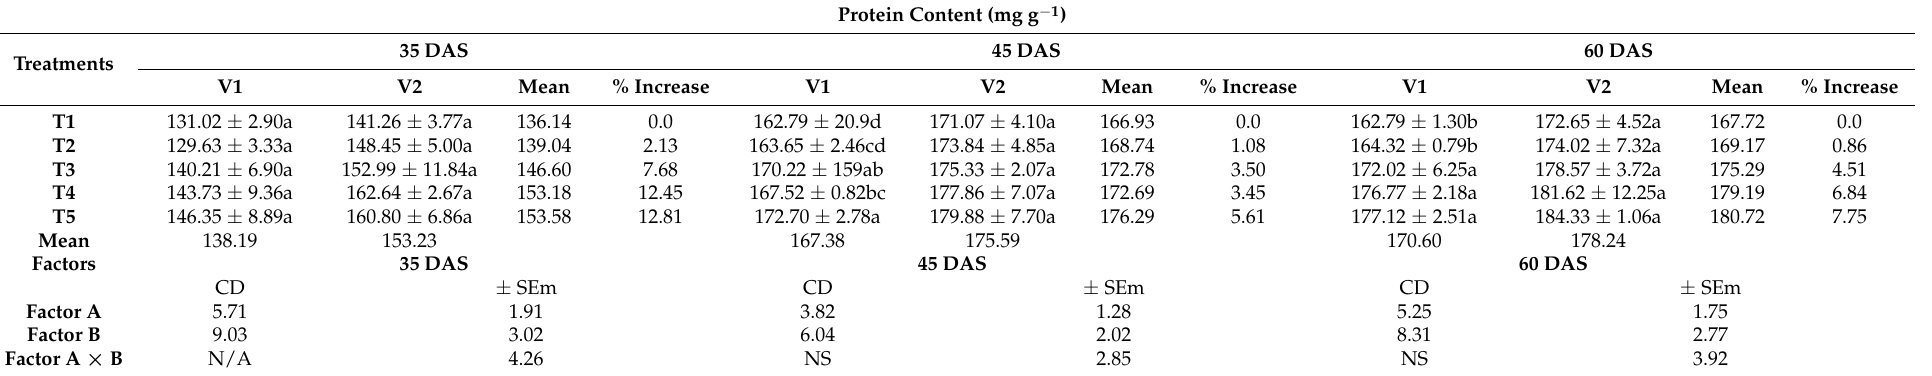
Table 7. Effect of hydro, Mg(NO 3 ) 2 , ZnSO 4 , Mg(NO 3 ) 2 + ZnSO 4 primed and nonprimed (control) seed treatments on protein content (mg g − 1 ) of leaves of wheat varieties, grown in